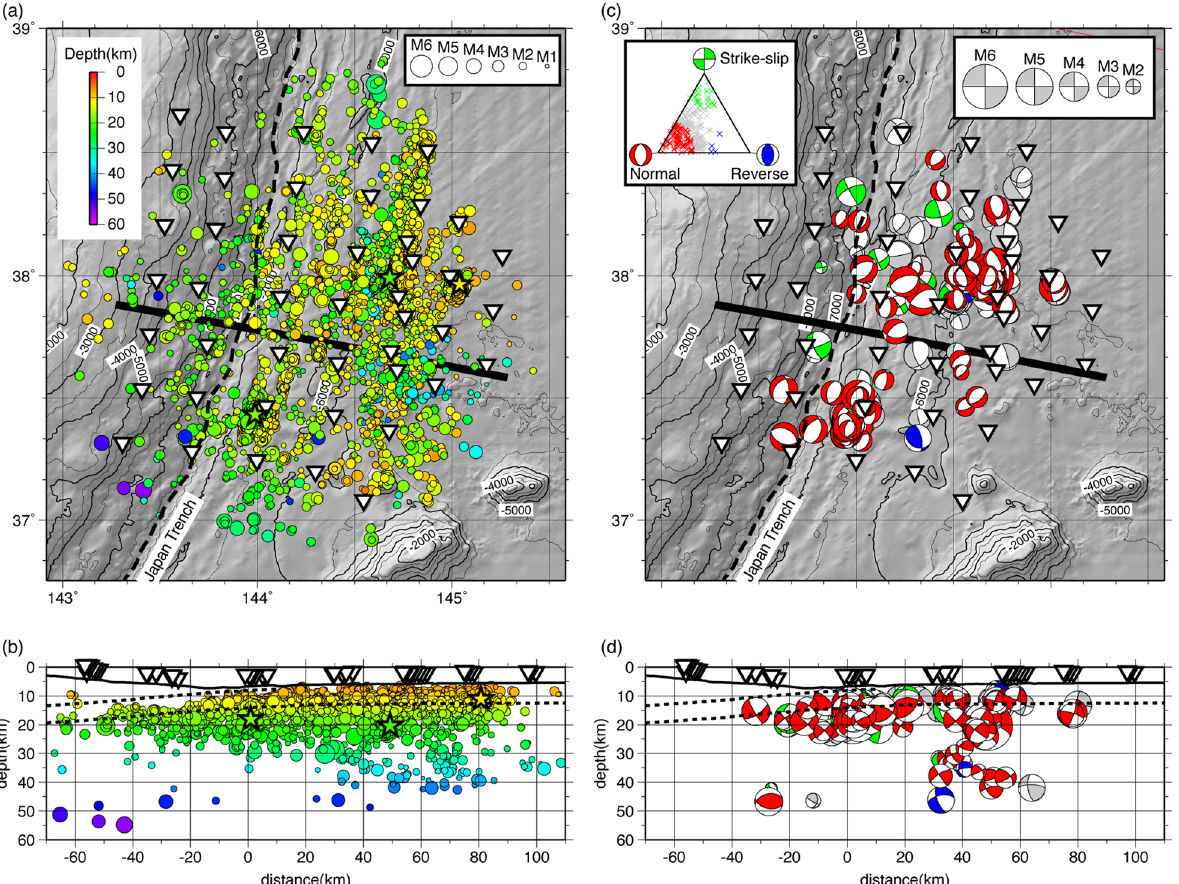
Fig. 2 Hypocenter distributions and focal mechanisms based on the tomographic analysis. a Map showing the hypocenters with location errors less than 5 km. Three M6-class earthquakes and others are indicated by stars and circles, respectively. The symbols are color-coded by hypocenter depth. Inverted triangles indicate the OBS locations. b Hypocenter distribution projected along the profile is indicated by thick solid lines on panel ( a ). Dashed black lines indicate the top of the oceanic crust (Ito et al. 2005) and the approximate depth of the Moho, which is 7 km below the seafloor seaward of the trench and 6 km below the top of the oceanic crust landward of the trench. Inverted triangles indicate the projected locations of OBSs. c Focal mechanisms estimated from first-motion polarities observed by the OBSs. Focal mechanisms are color-coded according to the triangle diagram of Frohlich (1992), as presented in the inset panel. d Focal mechanisms projected along the profile indicated by the thick solid line on panel ( c